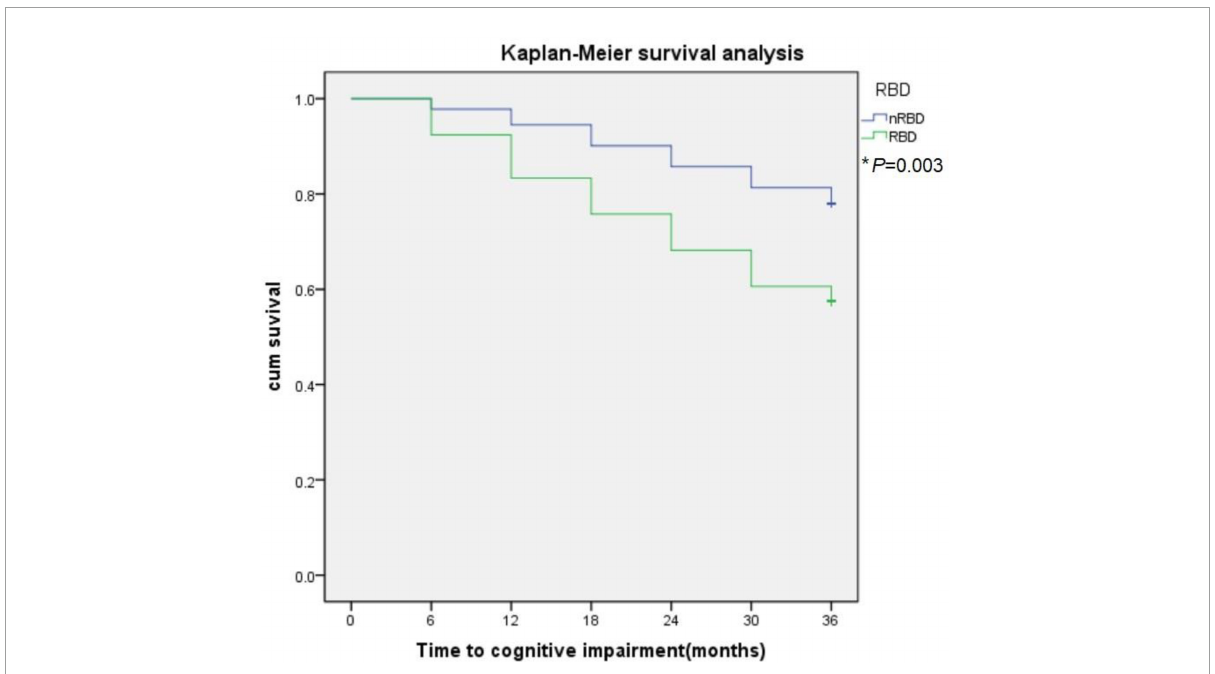
FIGURE5 The effect of RBD on global cognitive decline in PD subjects. RBD predict conversion to cognitive impairment (CI). Kaplan-Meier survival analysis was used to estimate the effects of RBD on the progression to CI. * P value statistically significant.